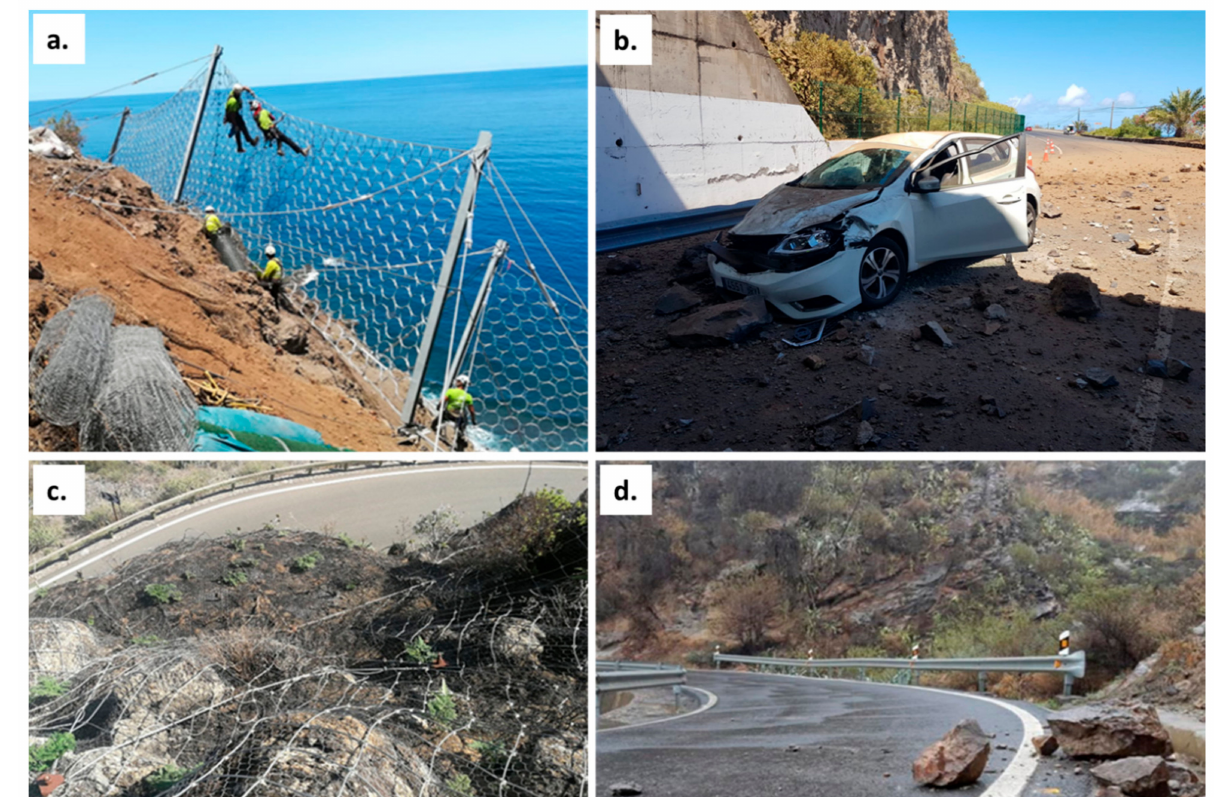
Figure 14. ( a ) Installation of dynamic barriers on the slope affected by rockfalls in Tenerife test site; ( b ) vehicle affected by rock impact at km 43 of the TF-5 highway (photos courtesy of V-Traverca). ( c ) Fence and barrier affected by the wildfire in GC-210 (courtesy of V-Traverca). ( d ) Rockfall triggered by wildfire in Tejeda (courtesy of Road Service of the Canary